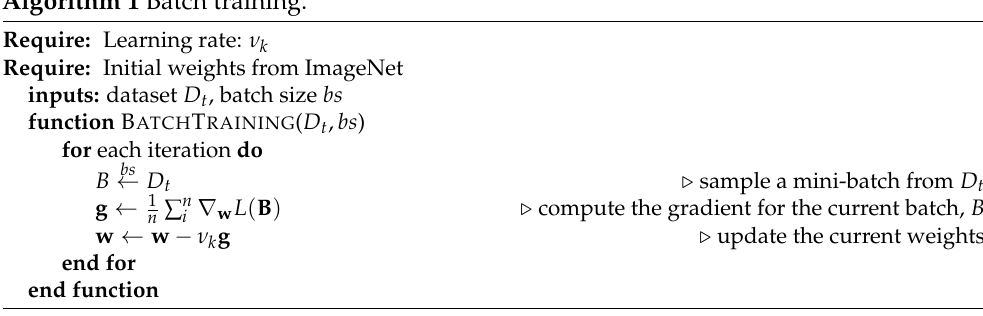
Algorithm 1 Batch training.